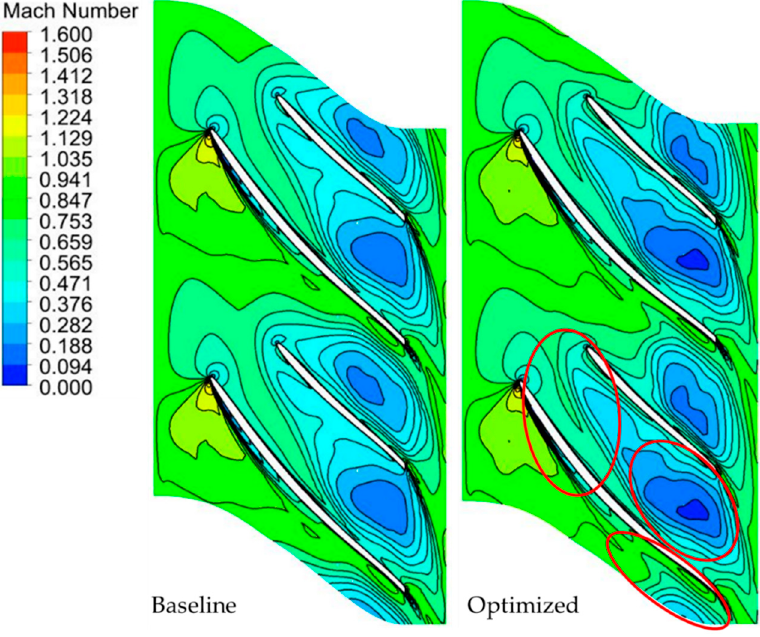
Figure 17. Mach number distribution for span 0.8 at the blade-to-blade contour.